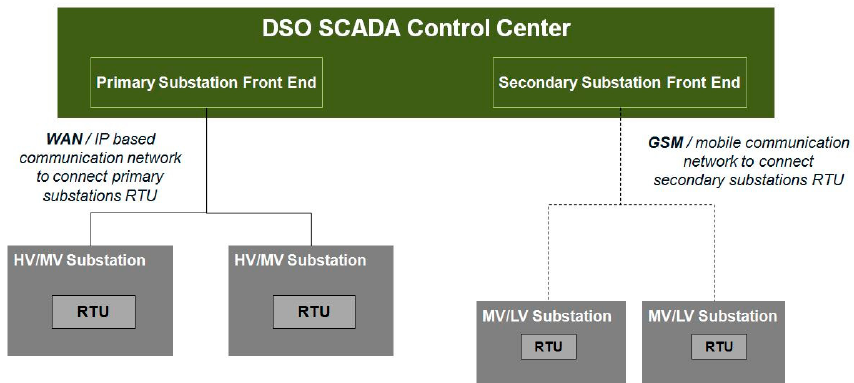
Figure 1. State of the art of the Supervisory Control And Data Acquisition SCADA in Italy.